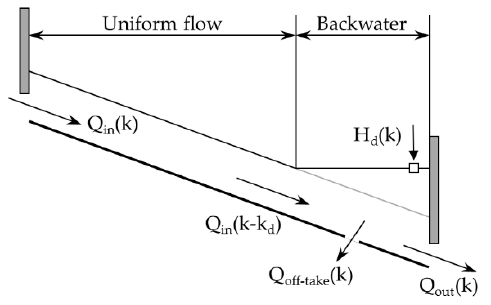
Figure 4. The verification to linear model.